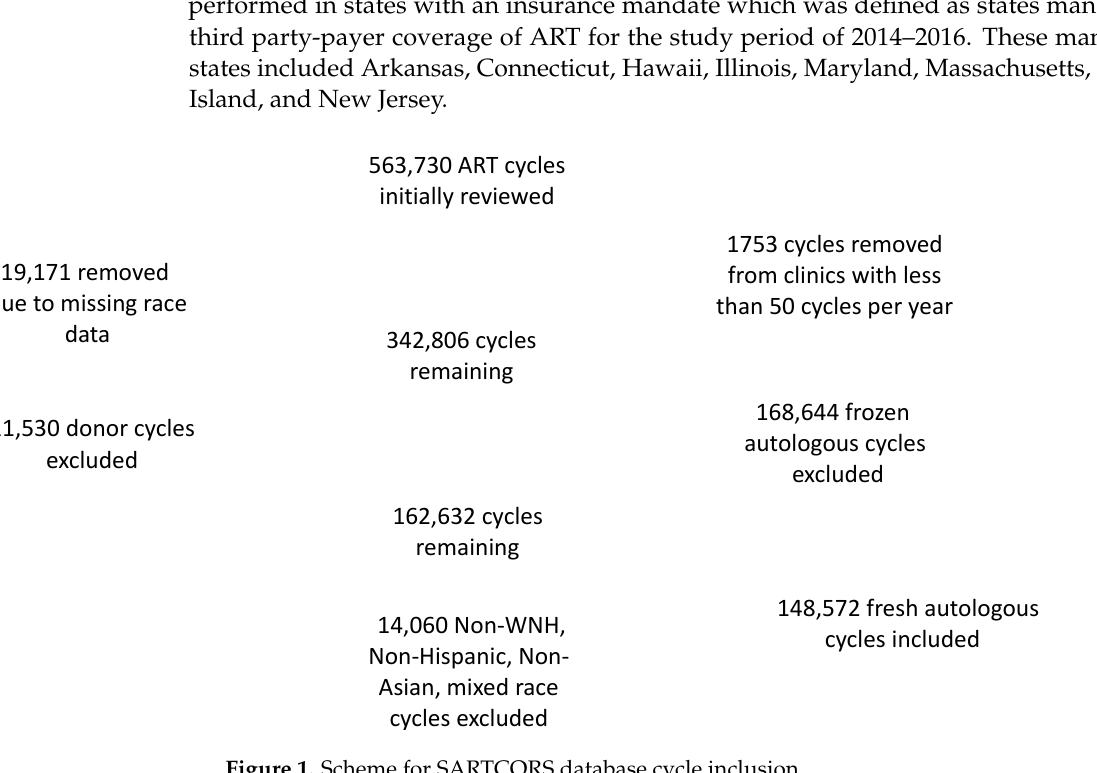
Figure 1. Scheme for SARTCORS database cycle